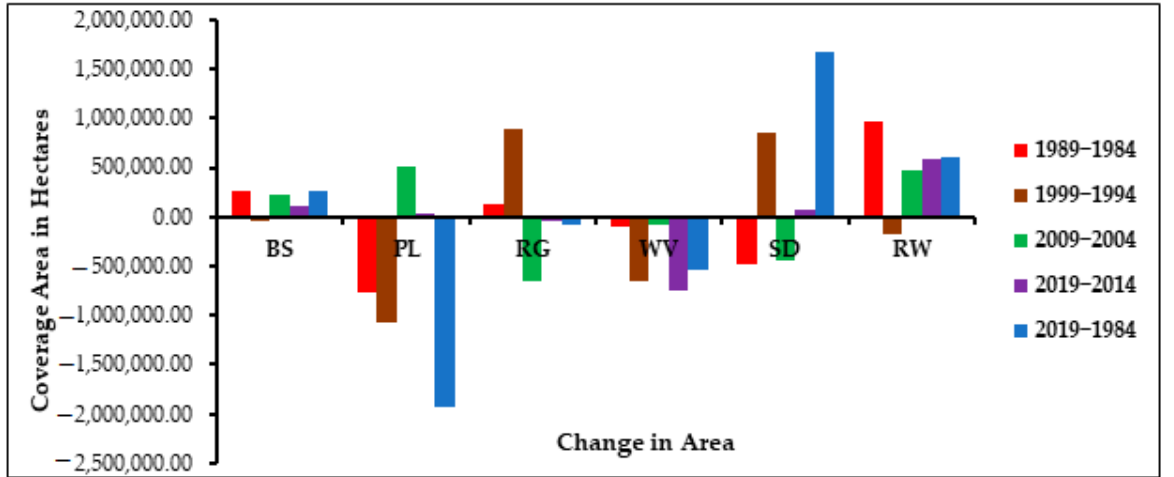
Figure 5. The magnitude of change for rainfed agriculture lands and other LULC types (BS = bare soil, PL = pastureland, RG = rainfed agriculture on goz land, SD = sand dunes, WV = woody vege- tation, RW = rainfed agriculture on wadi land) of North Darfur from 2019–1984. RW = rainfed agriculture on wadi land) of North Darfur from